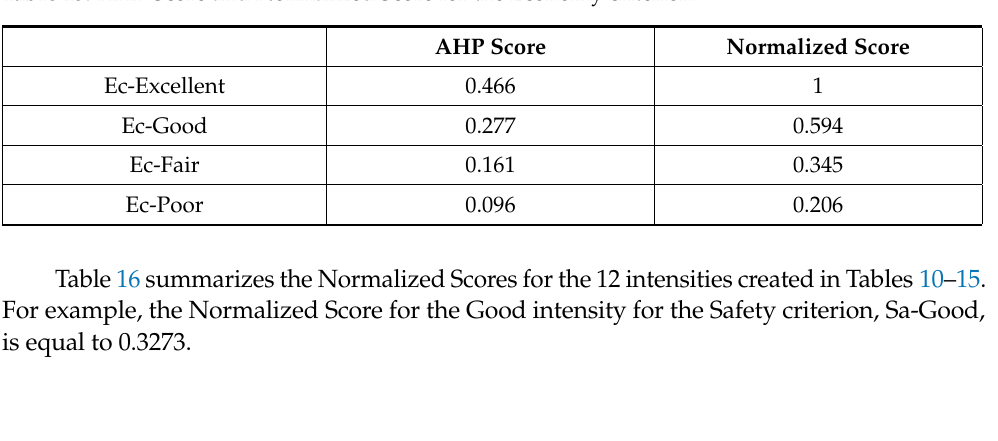
Table 15. AHP Score and Normalized Score for the Economy